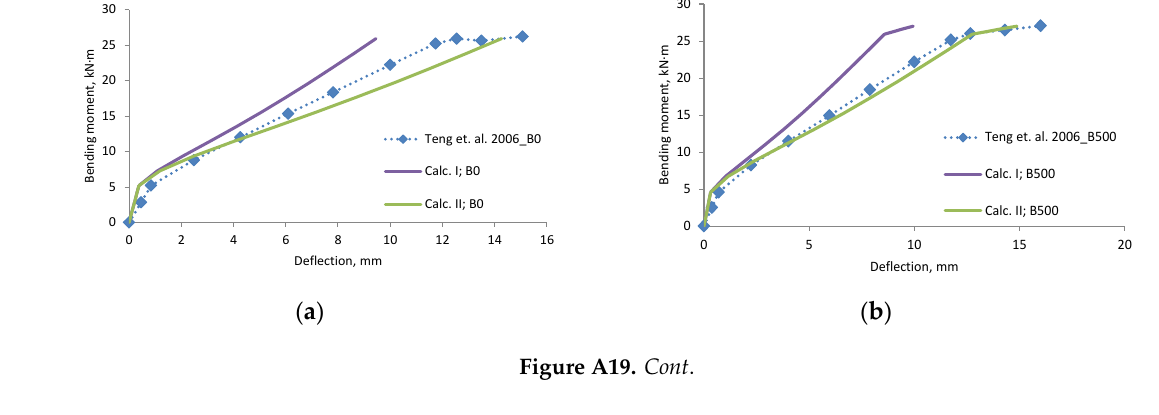
Figure A19. Cont